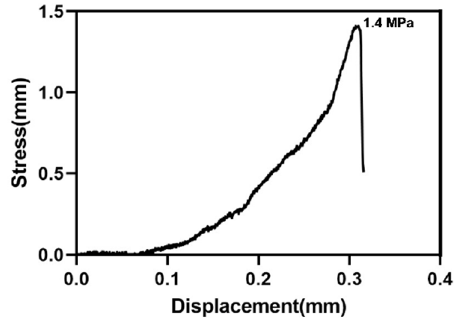
Figure 9. Stress–displacement curves for the deposited HA coating.